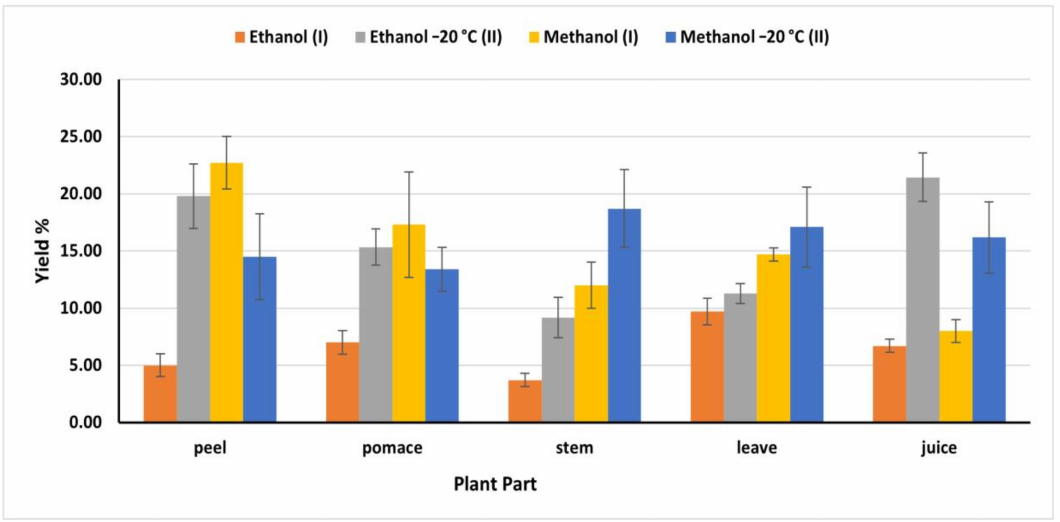
Figure 1. Yield of extraction of di ff erent solvents expressed in % of the dry matter; (I): IEM; (II): OEM at − 20 ◦